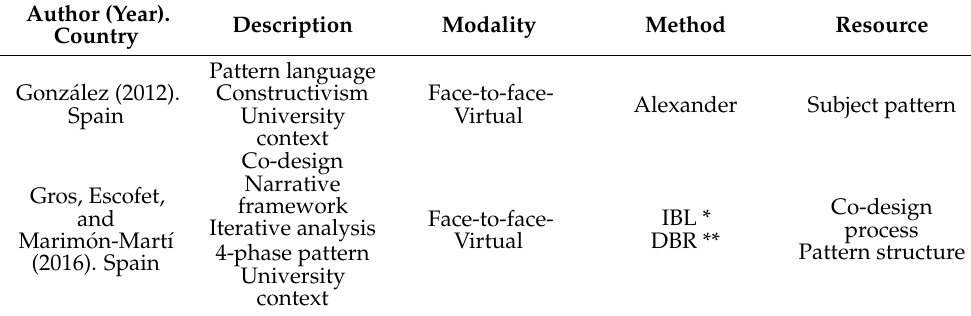
Table 3. Grid of works on pedagogical patterns in Spain. Author (Year). Country